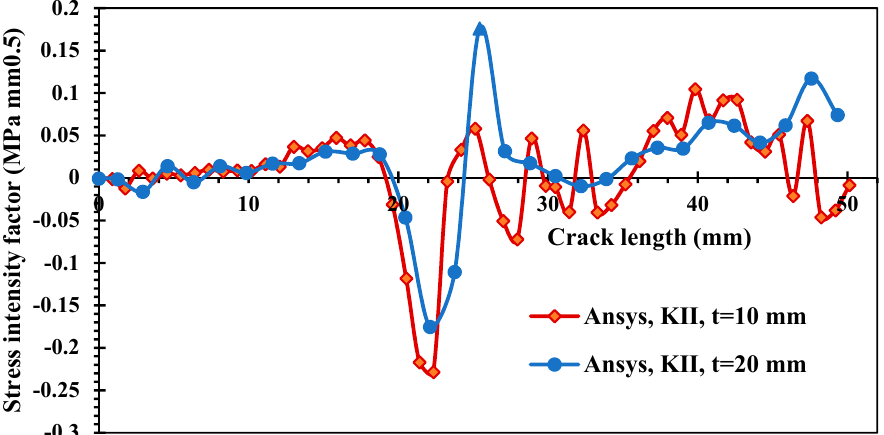
Figure 9. Results of the second mode of the stress intensity factor for different thicknesses.